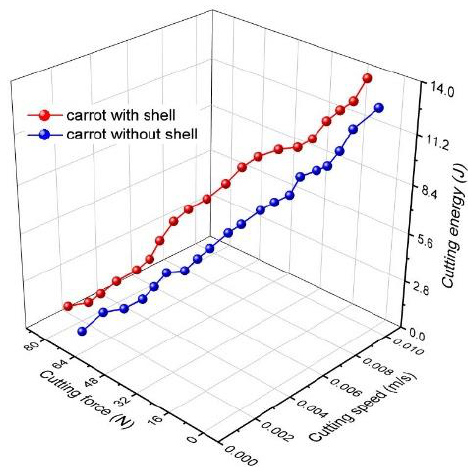
Figure 7. Variation in cutting energy for peeled and unpeeled carrots with different humidity levels as a function of cutting speed.